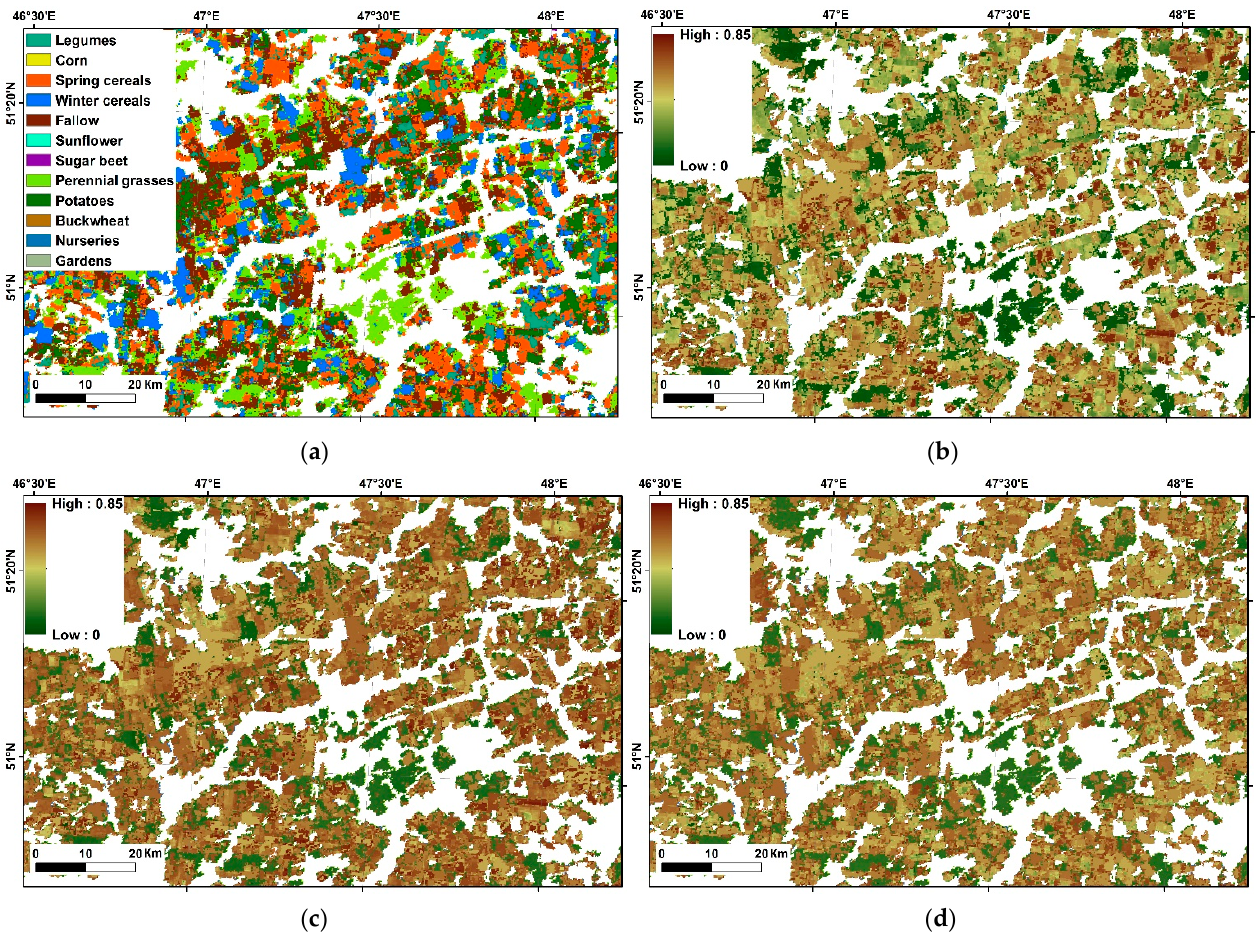
Figure 3. Result of interpretation of crops ( a ) and examples monthly estimates of the C-factor on arable land (( b )—June, ( c )—August, ( d )—October 2016) (fragment).